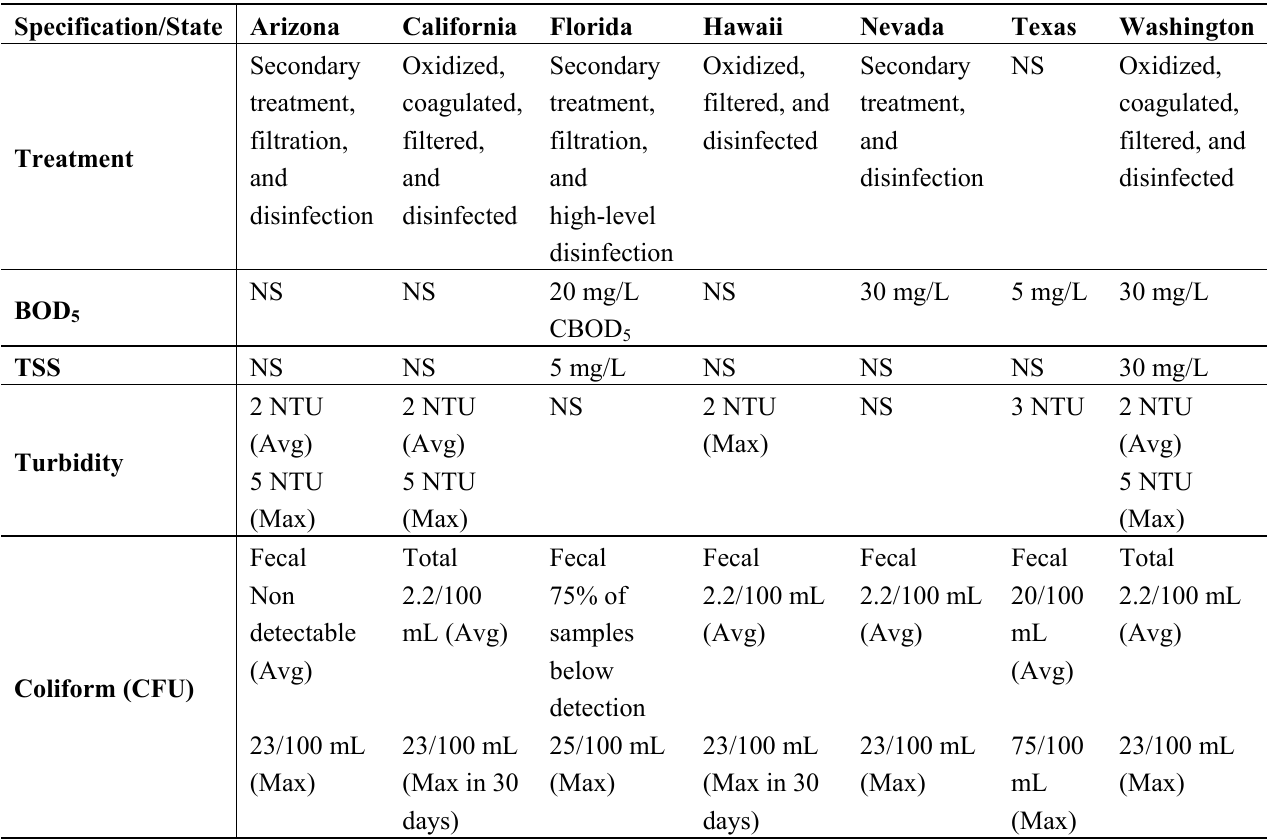
Table 7. State regulations for golf courses irrigation (USEPA, 2004) [29].